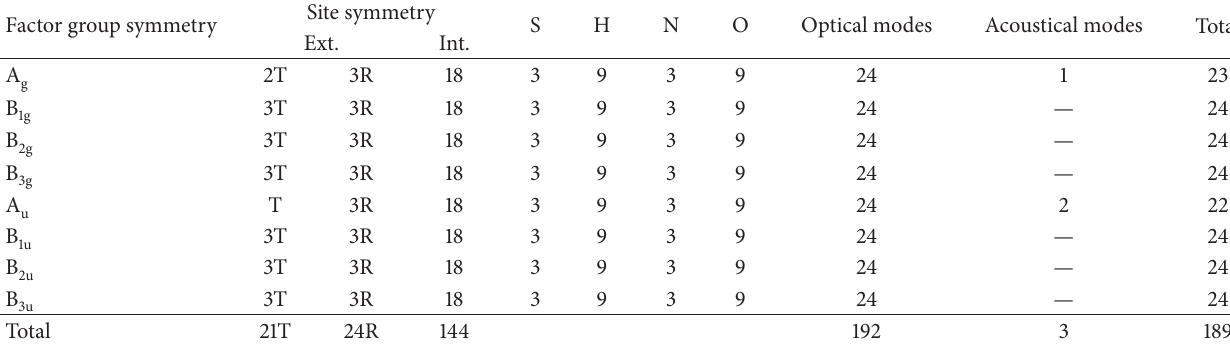
Table 3: Summary of factor group analysis.